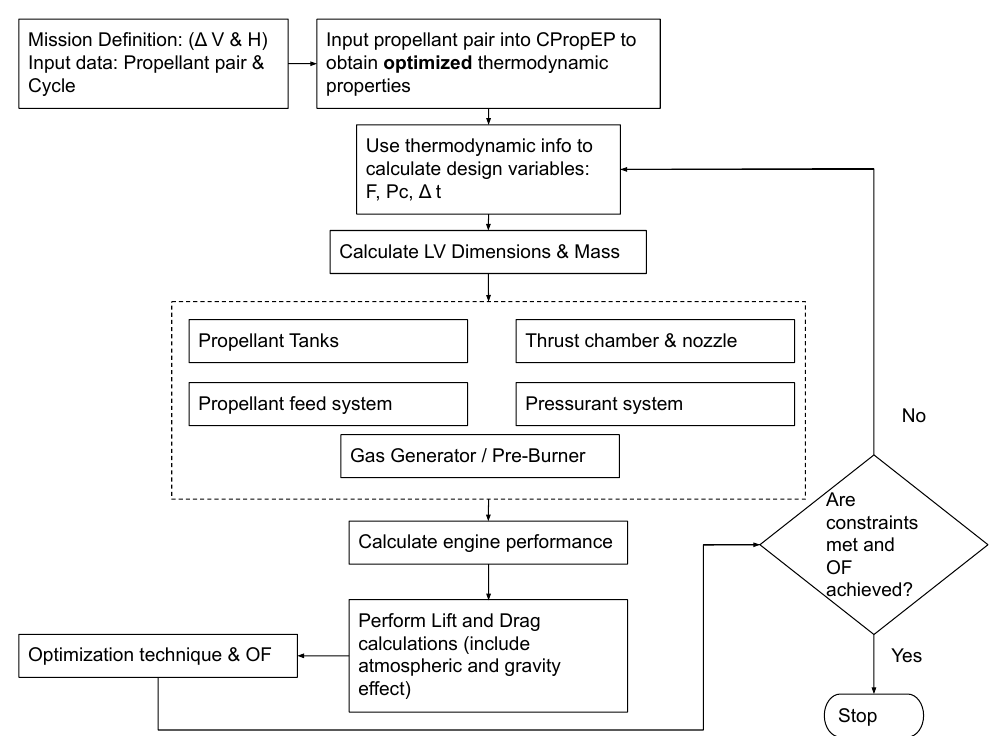
Figure 1. Optimization and modelling flow